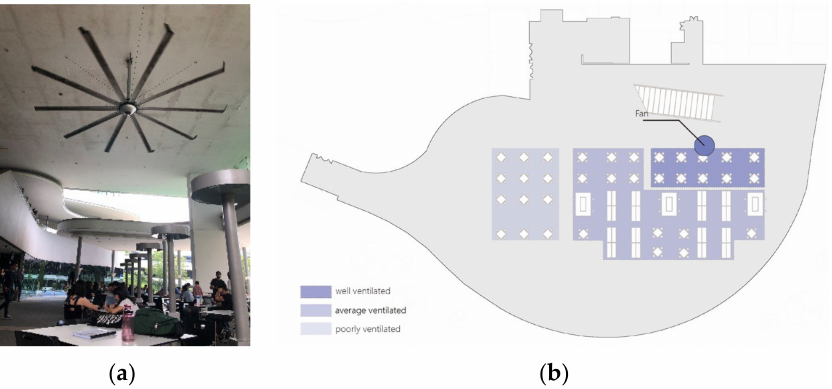
Figure 10. Fan location and seating division: ( a ) actual view of the fan location and ( b ) fan effect distribution diagram.